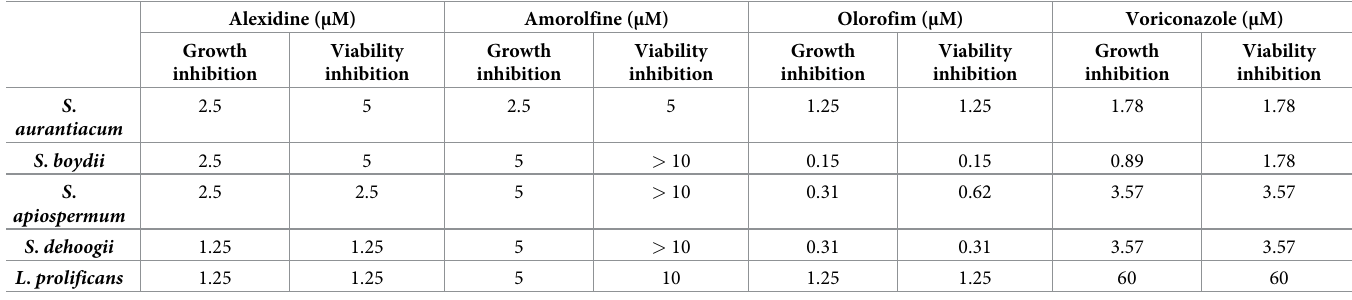
3I). Table 2. Minimum inhibitory concentration of alexidine, amorolfine, olorofim and voriconazole against several Scedosporium and Lomentospora species. Alexidine ( μ M) Amorolfine ( μ M) Olorofim ( μ M) Voriconazole ( μ